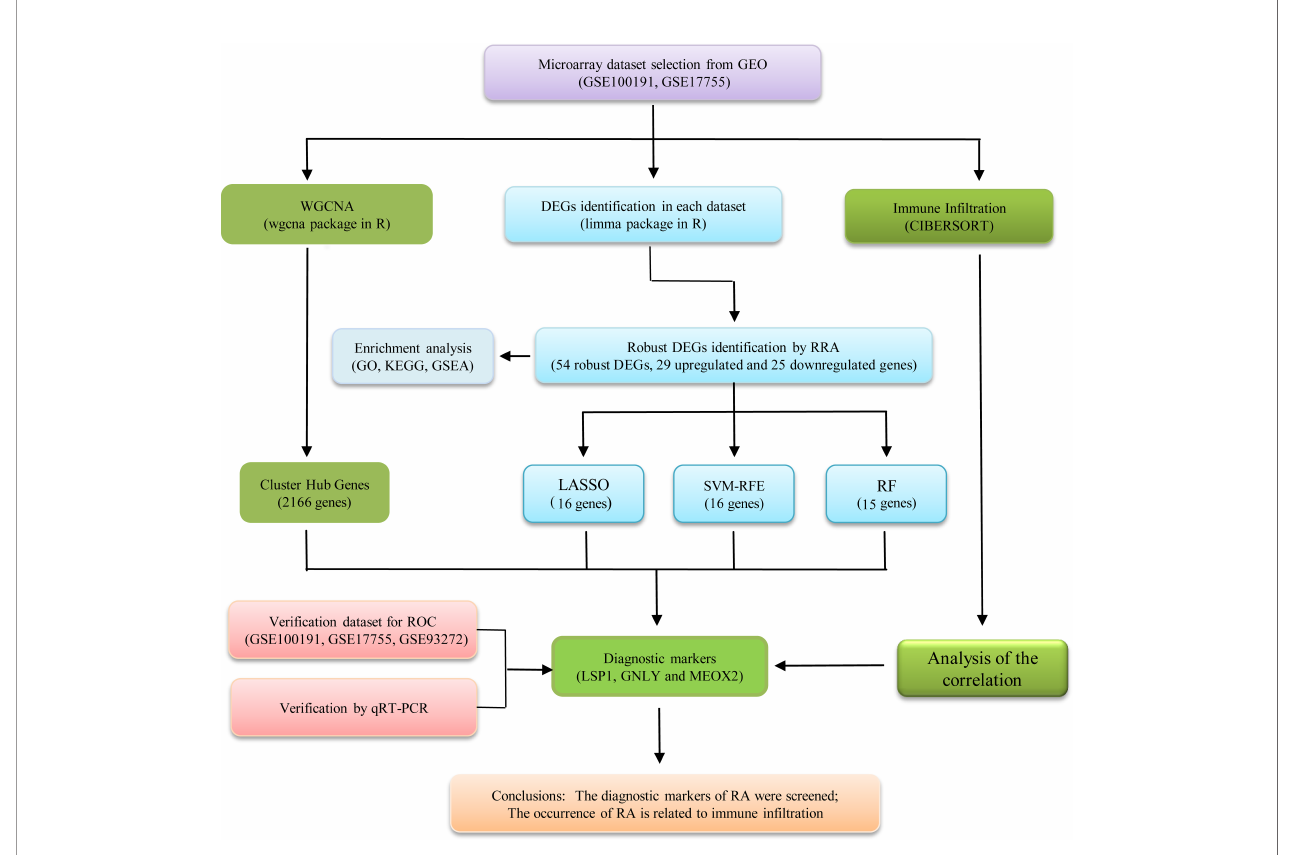
FIGURE 1 | The fl owchart of the analysis process.